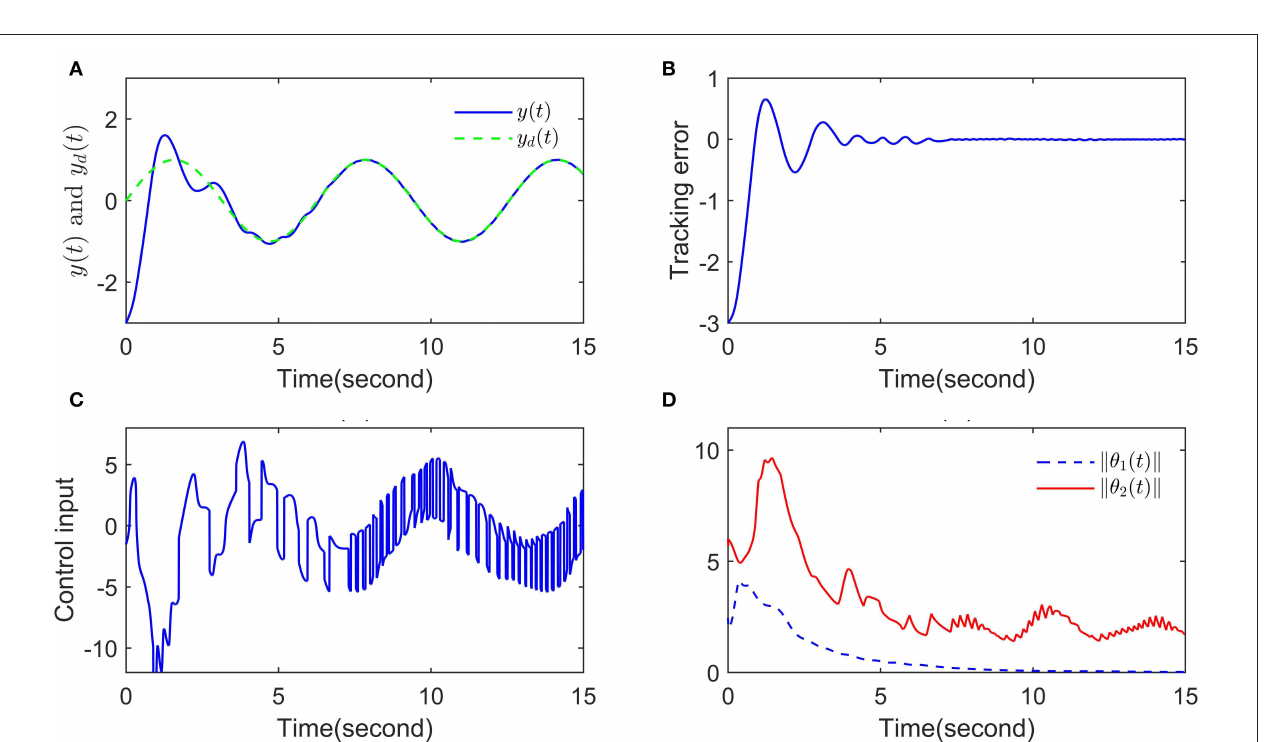
FIGURE 4 | The simulation diagrams, (A) The signals y ( t ) and y d ( t ), (B) The tracking error, (C) The control input, (D) The parameter norms of RBFNN.